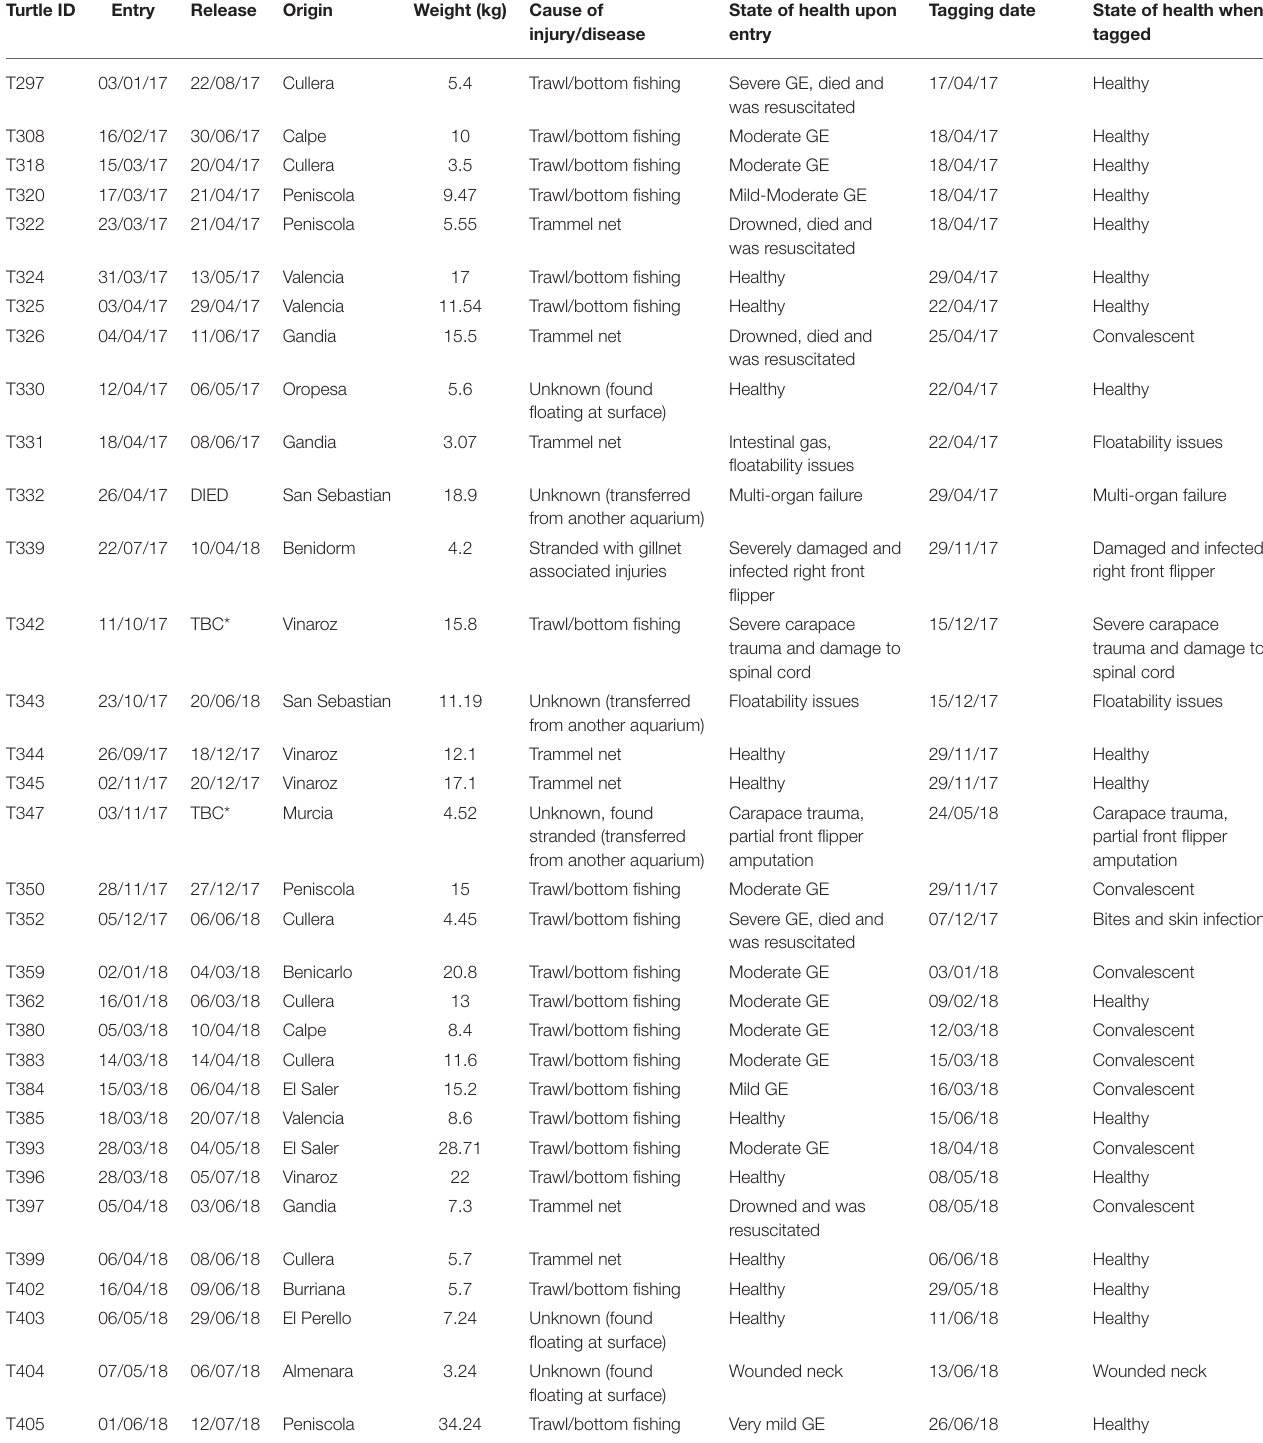
TABLE 1 | Summary of tagged turtle data including: turtle identification number, entry to and release dates from the rehabilitation center, bycatch origin, weight (kg), cause of injury/disease (when known), and the animals’ state of health upon entry, and on the date of tagging (as deduced via veterinary examination). Turtle